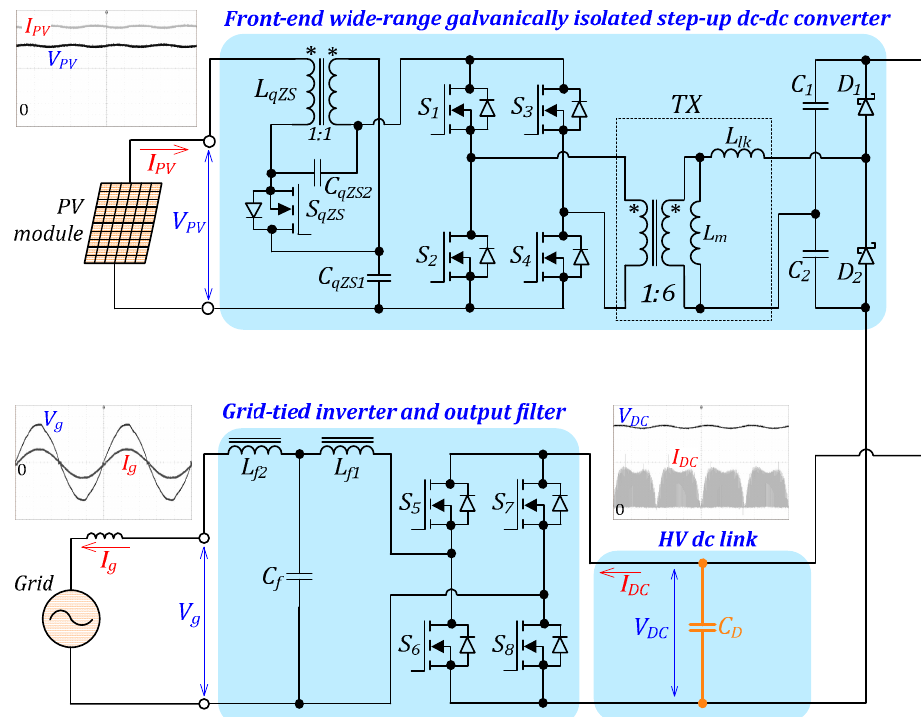
Figure 3. Topology of the case-study shade-tolerant microinverter [18].